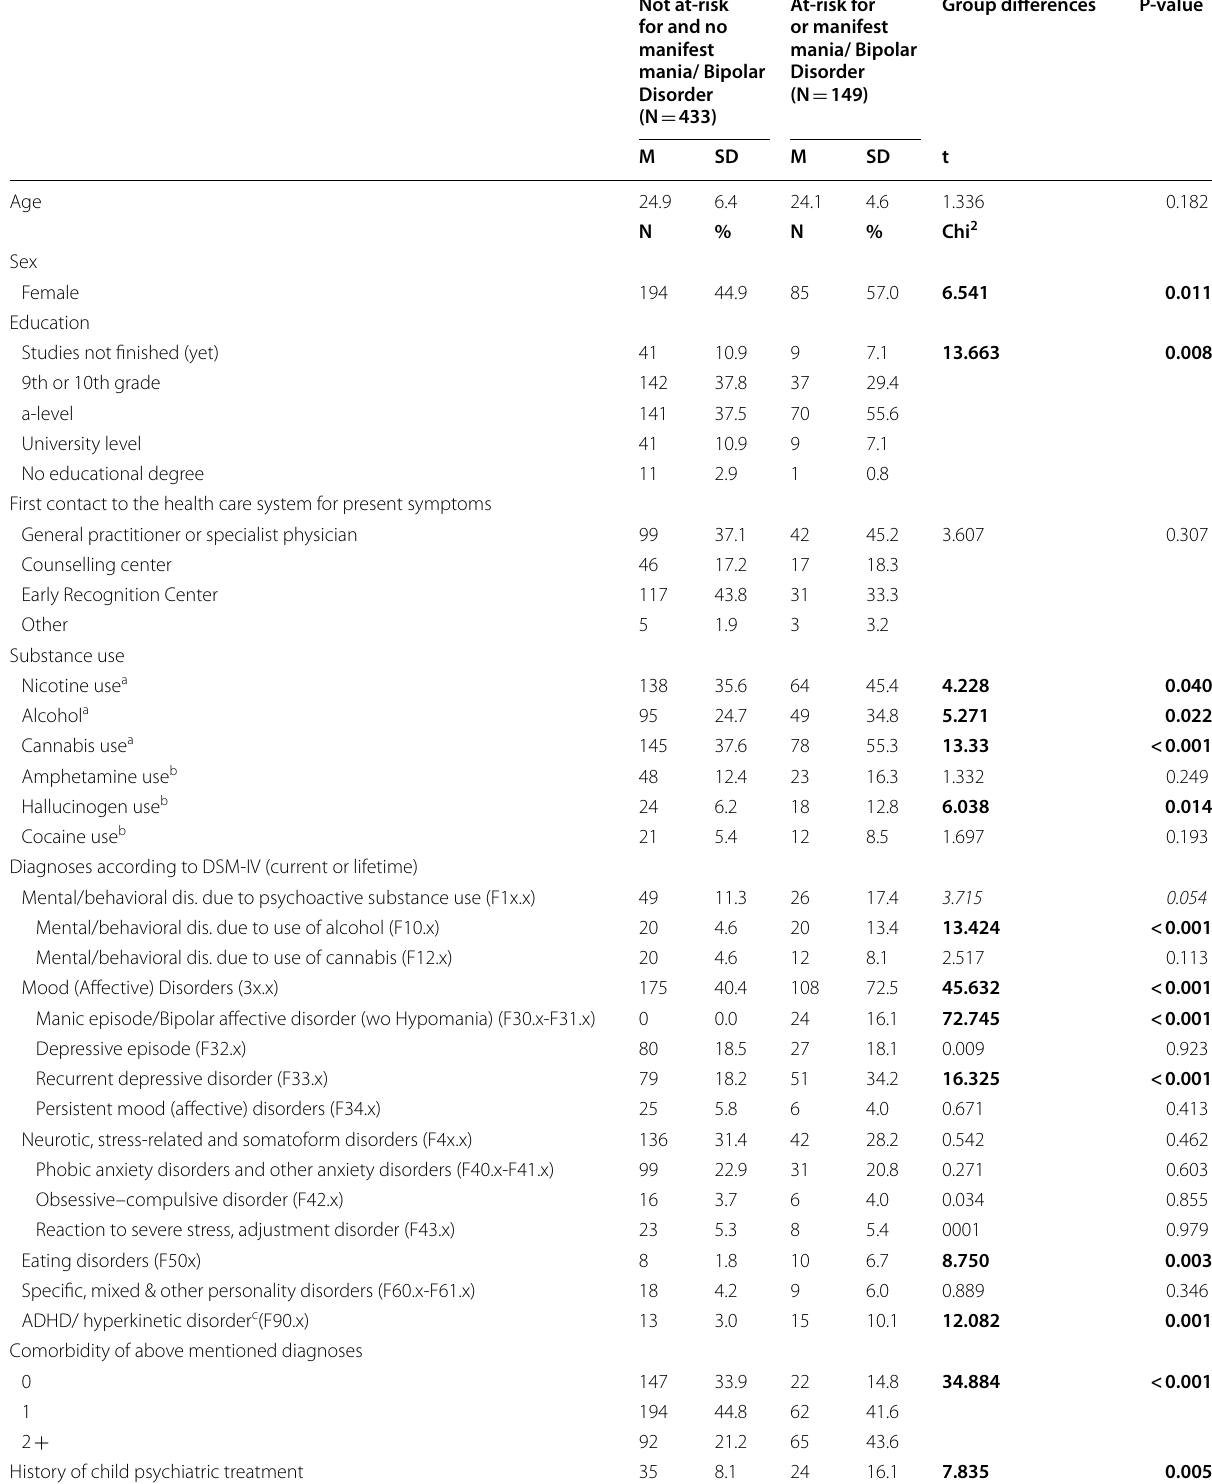
Table 1 Sociodemographic and clinical characteristics of help‑seeking adolescents and young adults completing the diagnostic process with vs without BD at‑risk/manifest BD status (N